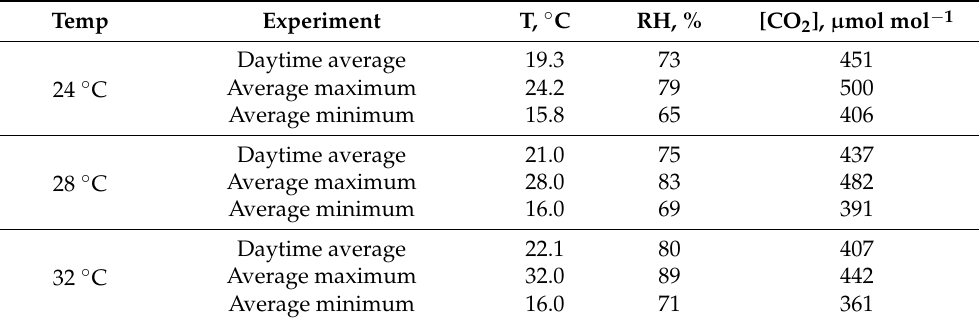
Figure 1. Daily programming of climatic conditions inside the growth chamber: photosynthetically active radiation (PAR), relative humidity (RH), CO 2 concentration, and temperature for treatments T24, T28, and T32. Table 2. Mean of the daily, maximum, and minimum values of temperature, relative humidity, and CO 2 concentration recorded during the experiments corresponding to thermal treatments: 24 ◦ C, 28 ◦ C, and 32 ◦